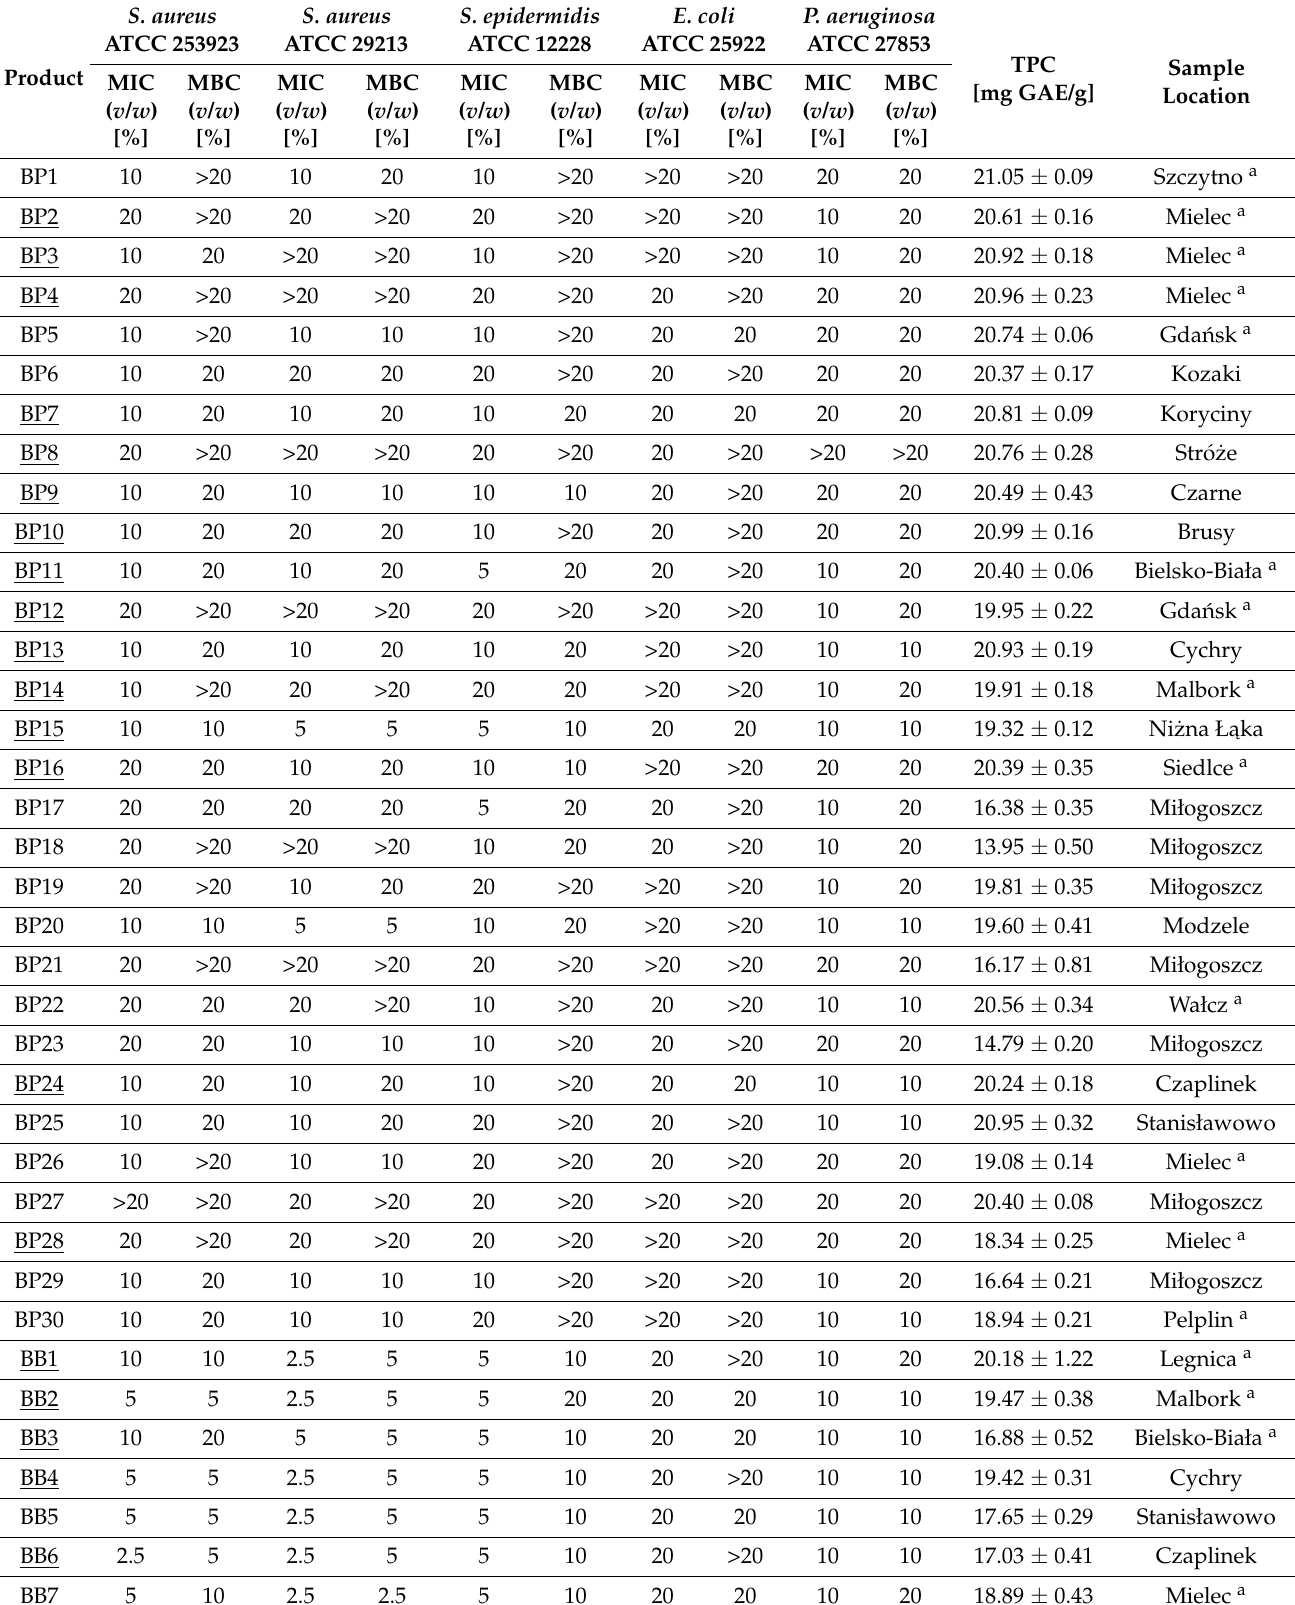
Table 1. Antimicrobial activity and total phenolic content (TPC) of extracts produced from bee pollen (BP) and bee bread (BB) samples harvested in Polish